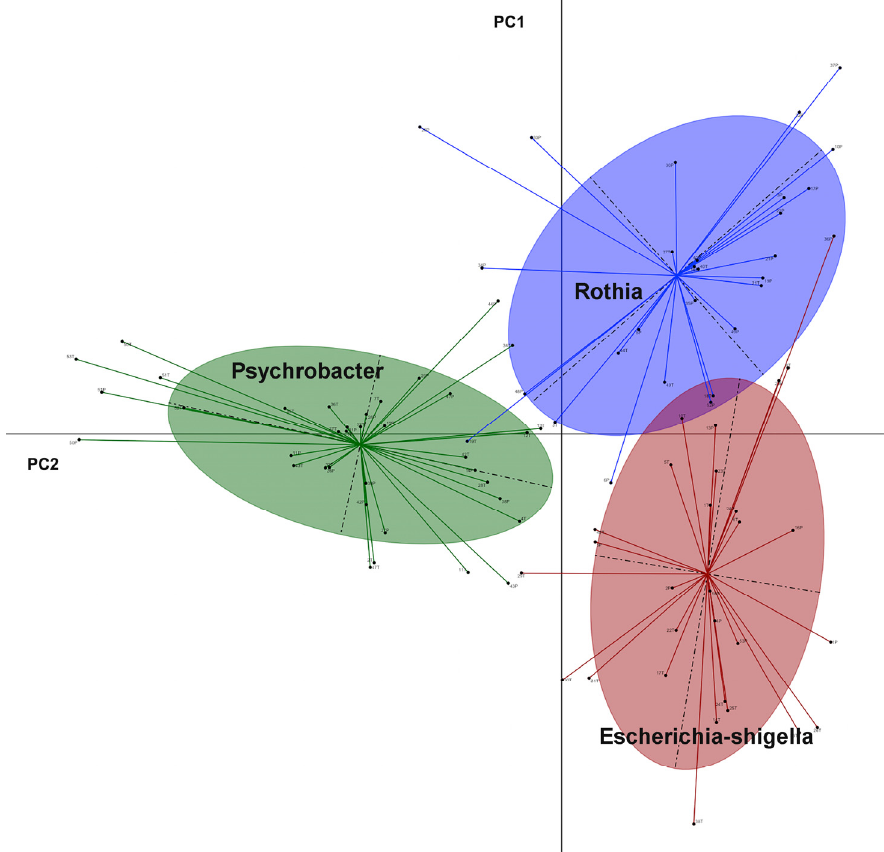
Figure 6. Enterotypes identified in the 94 breast cancer samples (tumor and adjacent tissues) using principal coordinate analysis (PCA). The blue cluster is enterotype 1 (Rothia), the green one represents enterotype 2 (Psychrobacter), and enterotype 3 is shown in brown (Escherichia-shigella).